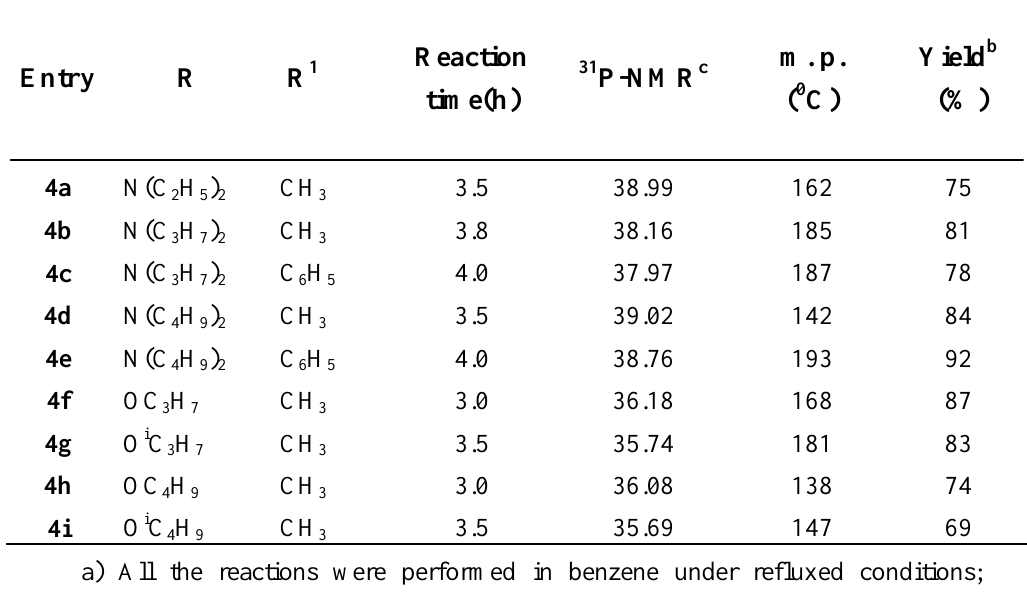
Table1 . Physical data of the newly synthesized compounds 4 a